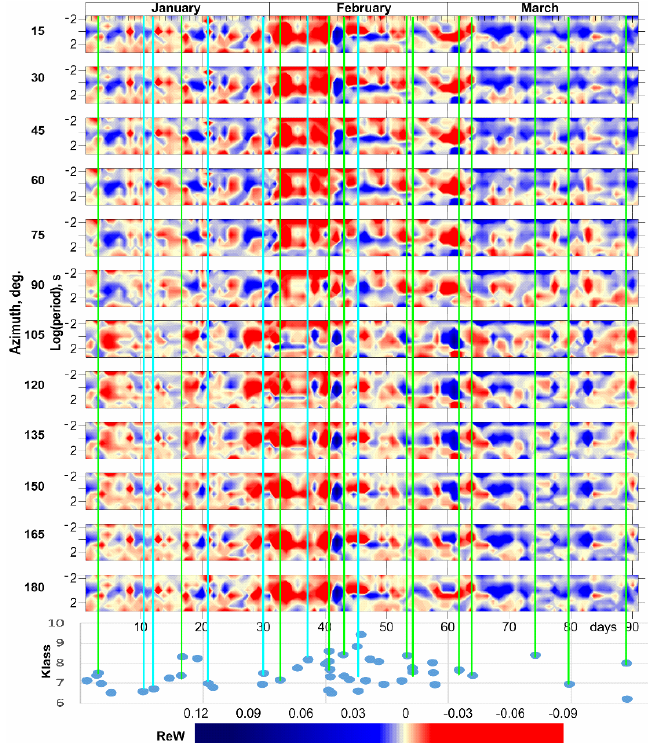
Figure 4. Time-frequency series of the azimuth MT ‐ monitoring (variations of magnetic tipper component) at the Ak ‐ Suu station in comparison with seismicity in January – March 2016 (ovals – seismic